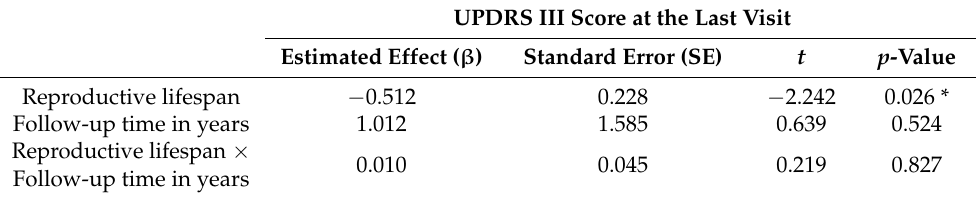
Table 3. Linear mixed effect of reproductive lifespan on the UPDRS III score at the last visit in the female PD